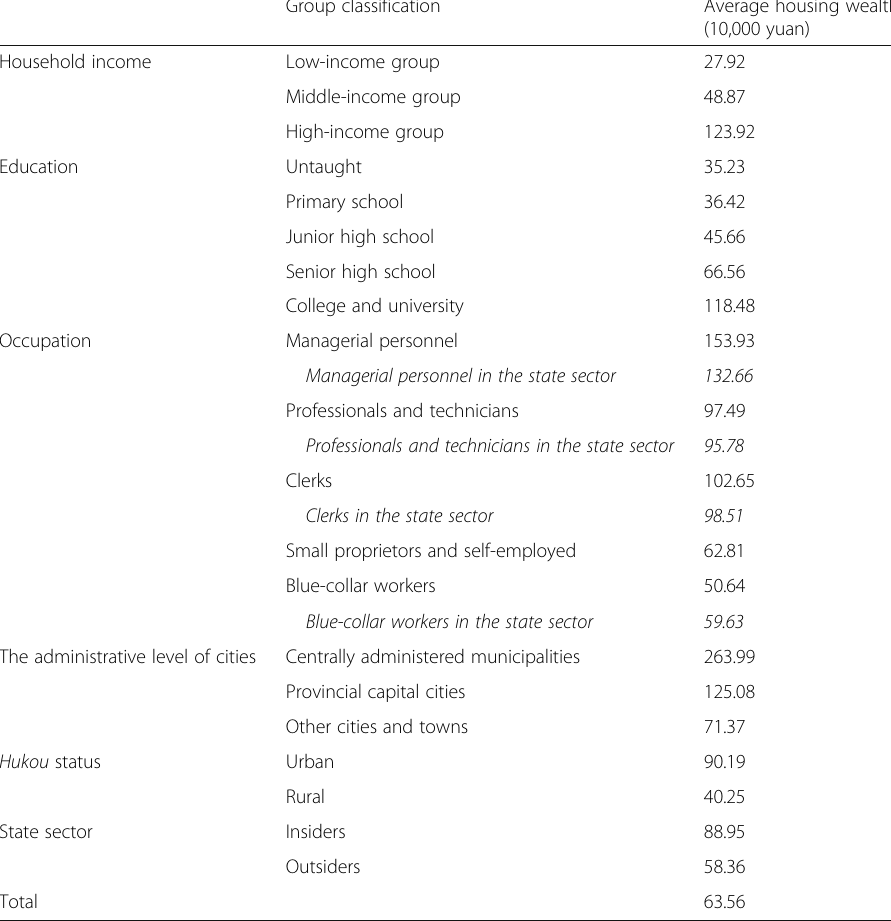
Table 2 Analysis on the difference of average housing wealth owned by different groups (2017, urban areas, N =